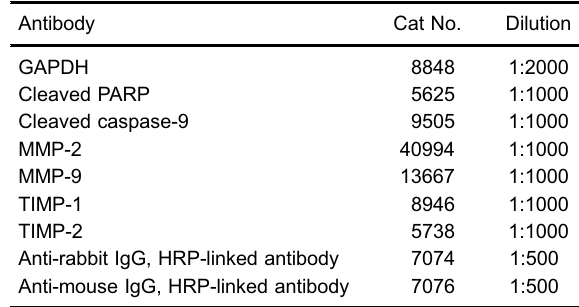
Table 1. Antibodies used in the